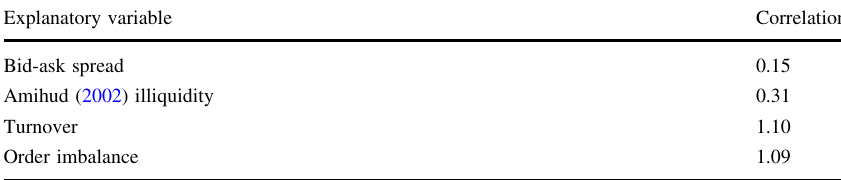
Table 9 Correlation of explanatory variables and error terms (all values in percent) Explanatory